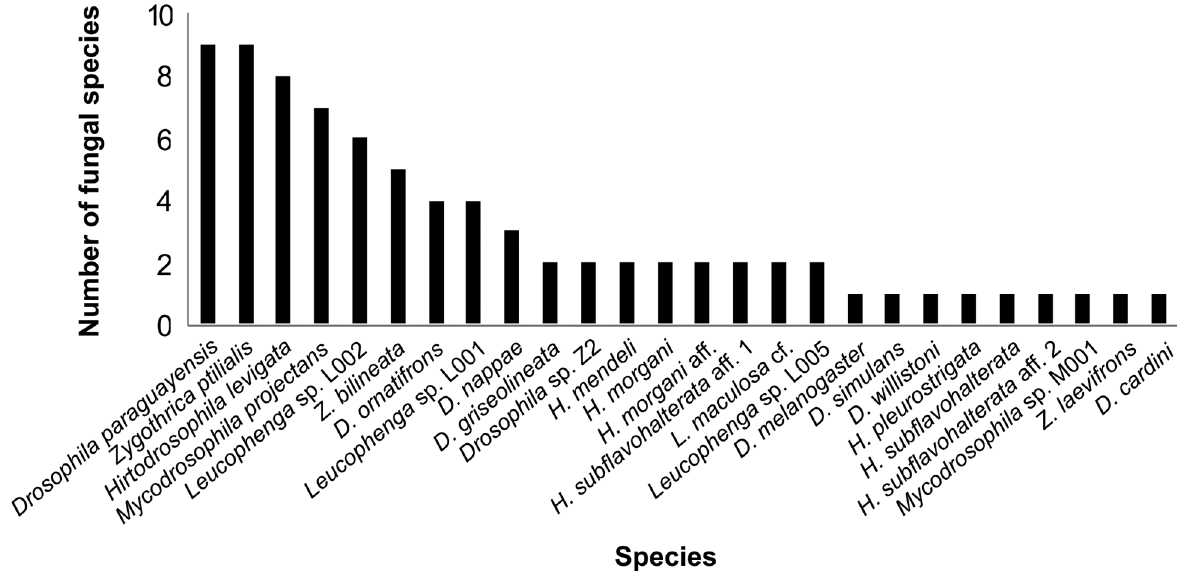
Figure 4 - Number of Basidiomycetes fungal species used by each species of